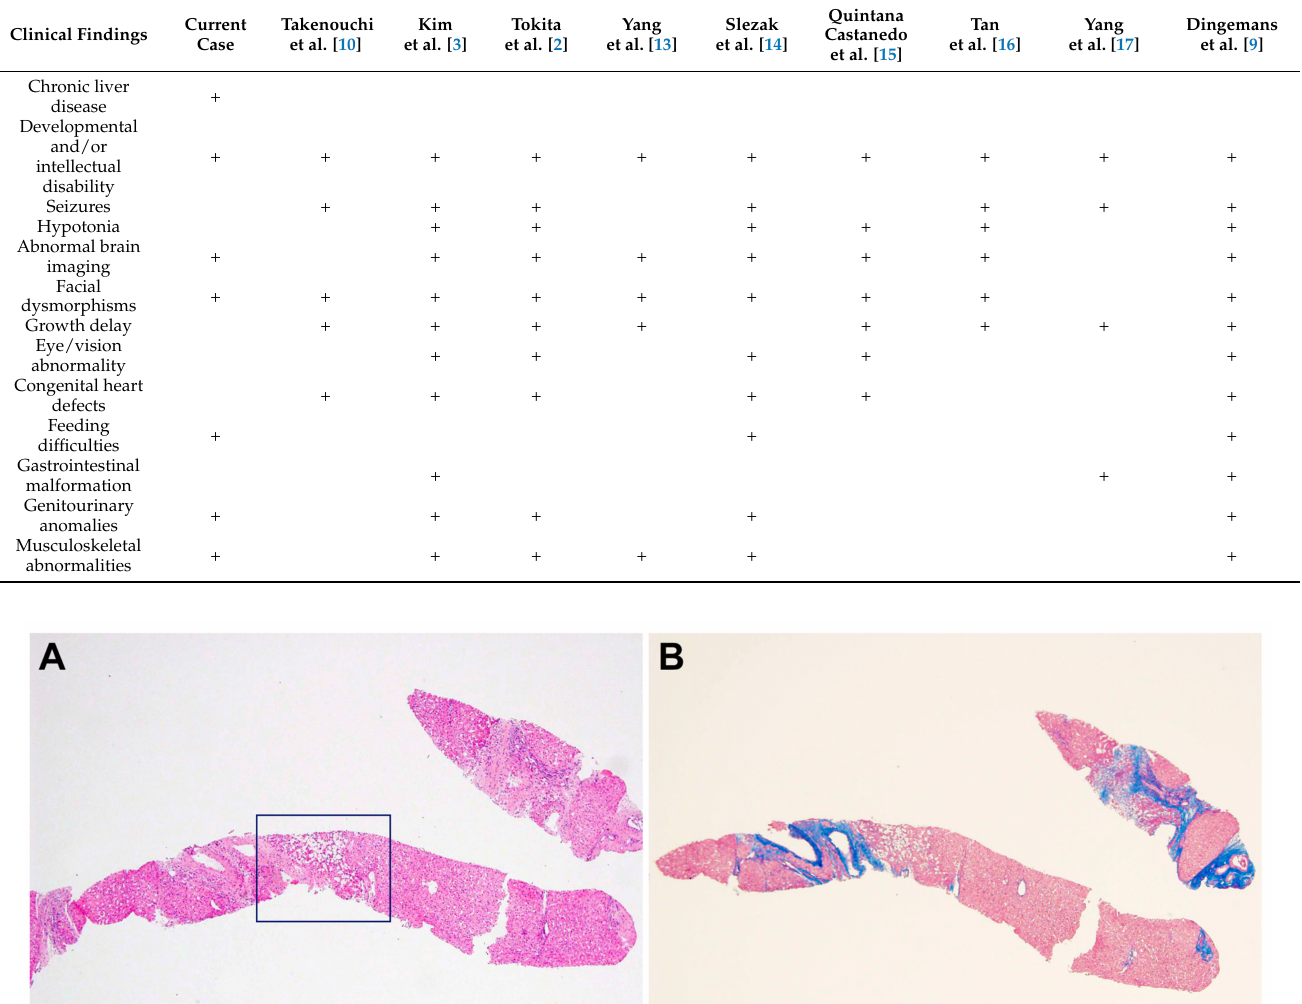
Table 1. Clinical characteristics of previously reported patients with ZTTK syndrome.